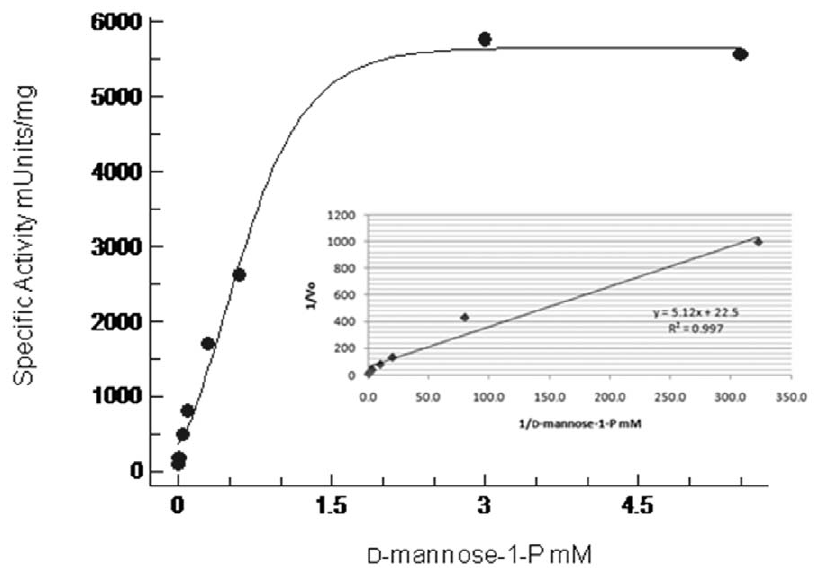
Figure 4. Mechaelis-Menten diagram depicting C.burnetii CBU0294 (PMM) kinetic parameters. Reactions were carried out with D- mannose-1-P as the fixed substrate. Data points were fitted using Microsoft XLfit model 601. Inset: Cooresponding Lineweaver-Burk Plot, regression line calculated by least squares.